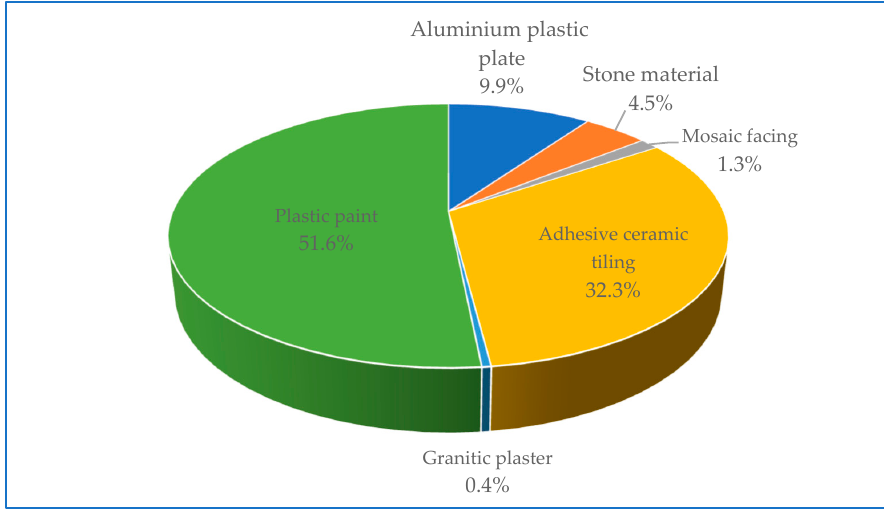
Figure 4. Proportion of various types of building finishes.